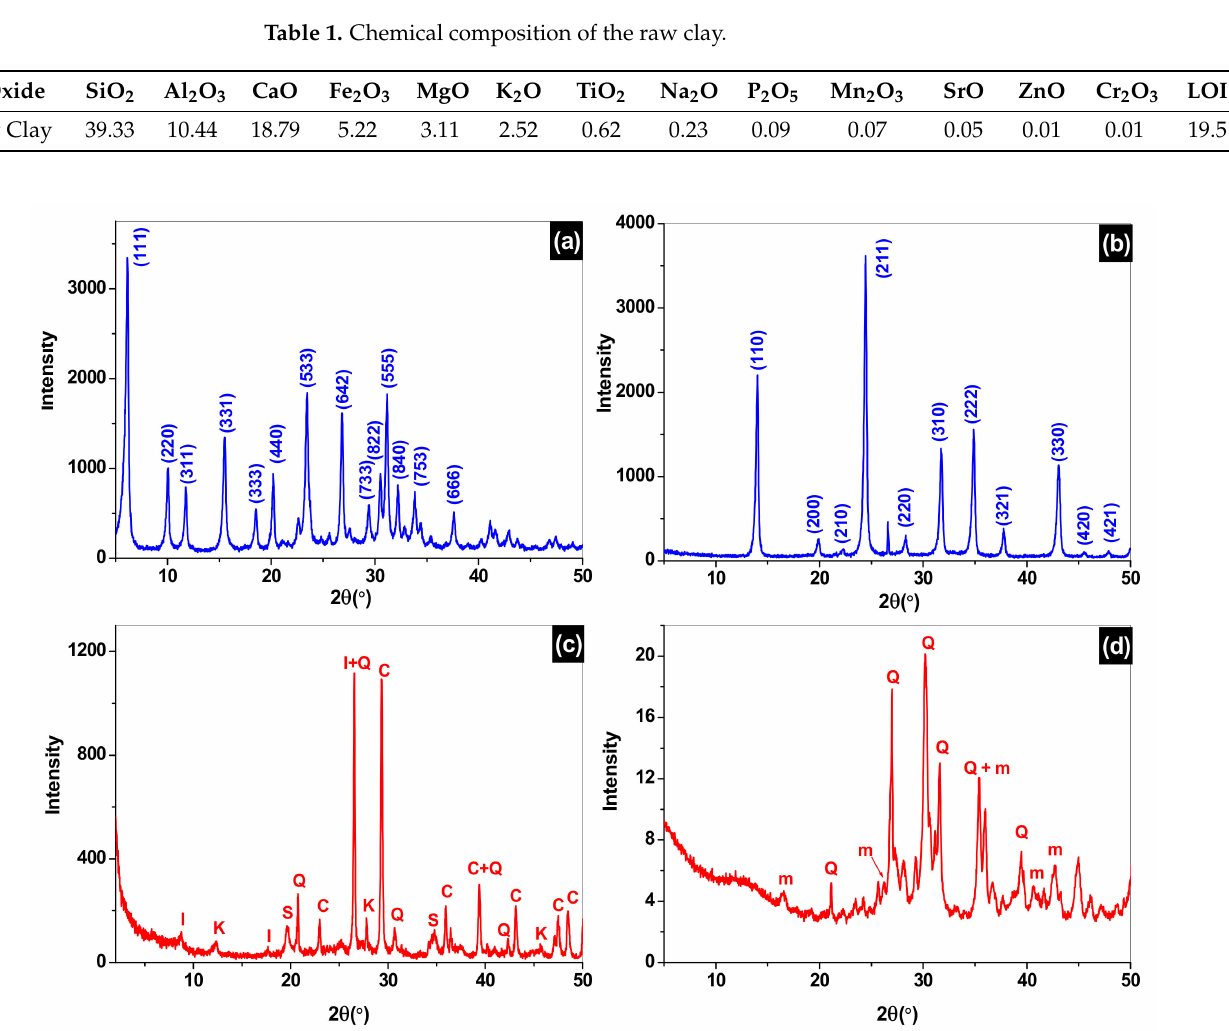
Figure 3. X-ray diffractogram of faujasite ( a ), sodalite ( b ), raw clay ( c ) and clay sintered to 1000 ◦ C ( d ). c: calcite, I: illite, k: kaolinite, m: mullite, Q: quartz, s: